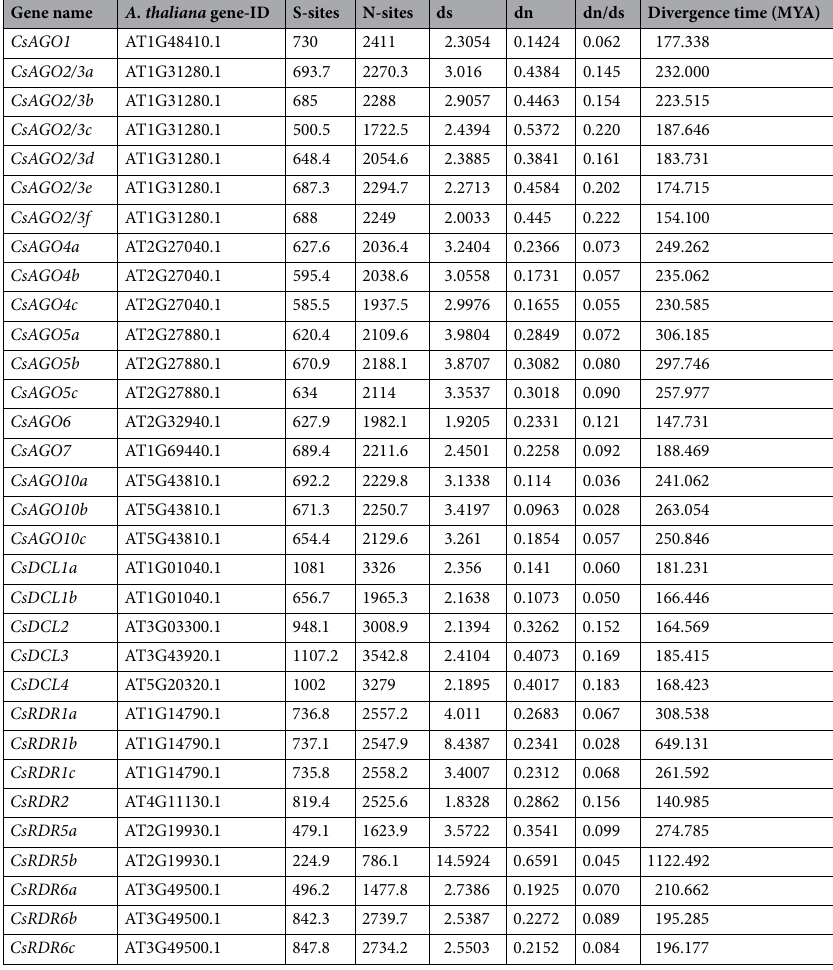
Table 3. Synonymous and non-synonymous substitution rates of orthologous gene pairs.